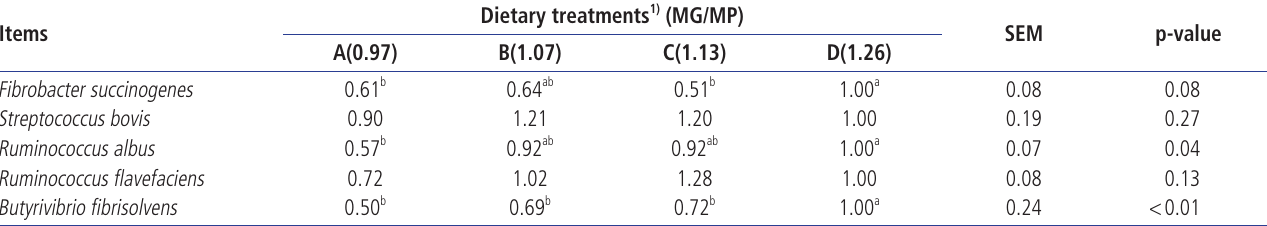
Dietary treatments 1)